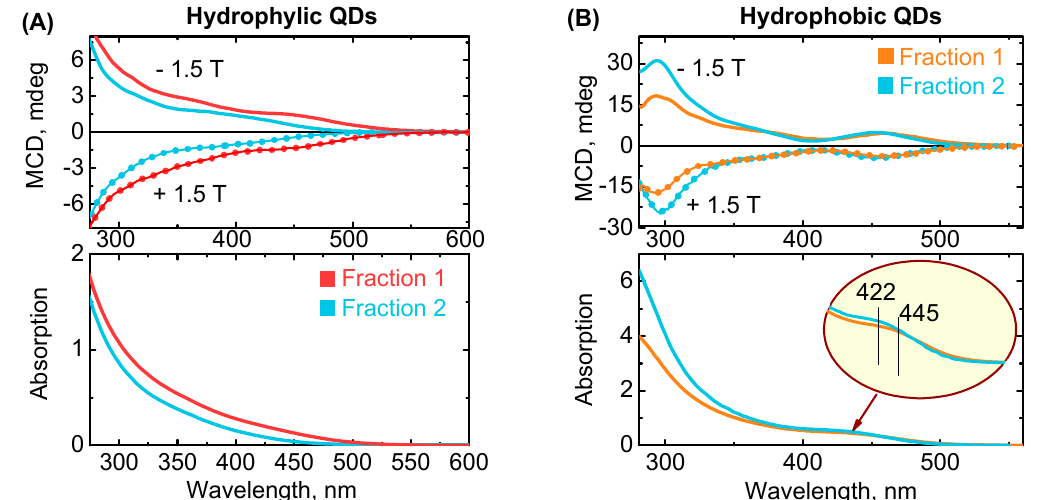
Figure 4. Magnetic circular dichroism (top) and corresponding absorption (bottom) spectra of two fractions of hydrophilic ( A ) and hydrophobic ( B ) AIS/ZnS QDs.